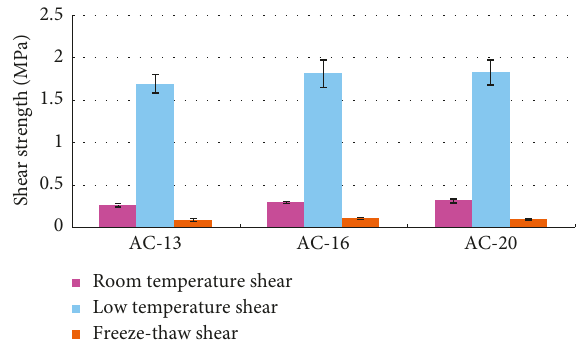
Figure 13: Comparison of test results from asphalt